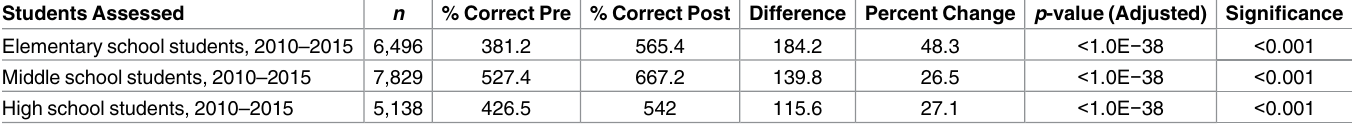
Data were processed by summing pre- and post-test values for each student across all test questions. Significance is estimated using a two-sided paired t - test and family-wise error rate-corrected using the Bonferroni